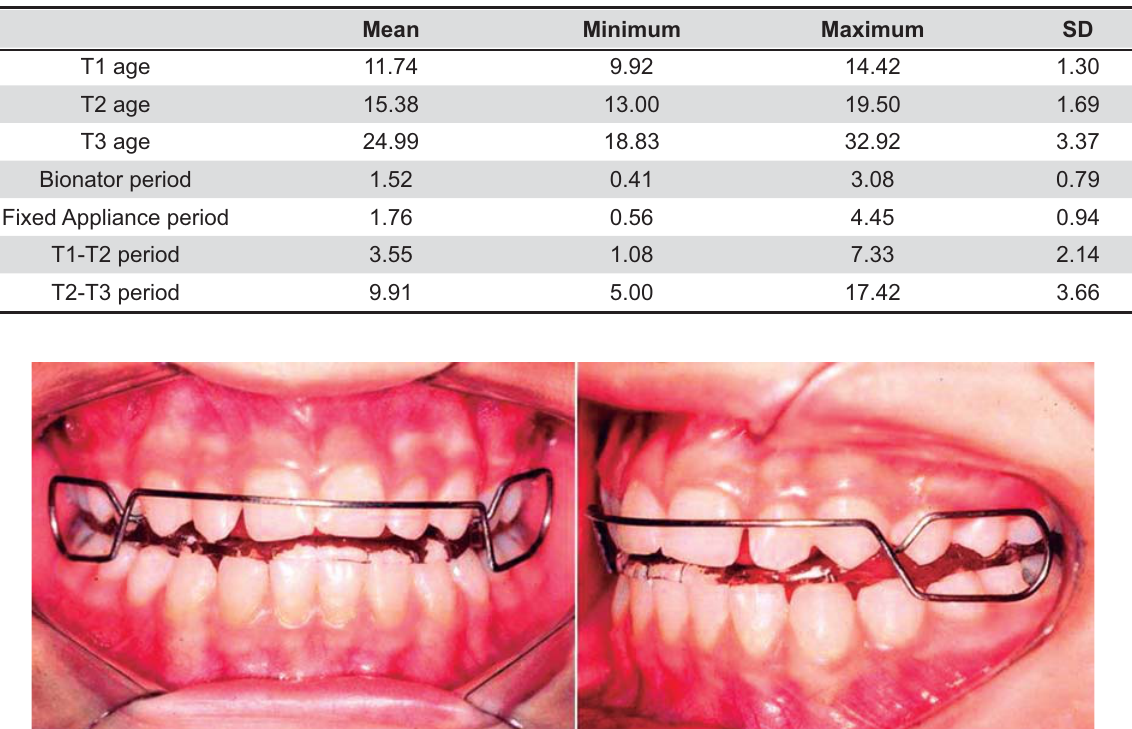
Table 1- Mean, standard deviation (SD), minimum and maximum values of the ages at T1, T2 and T3 and of the